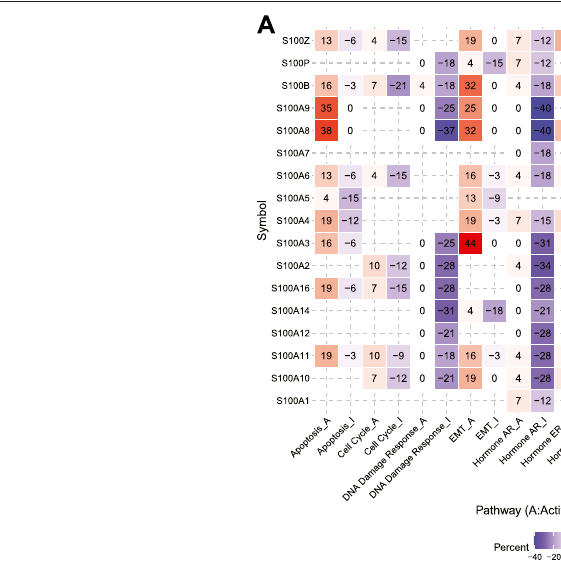
FIGURE8 | Cancer pathway activity and drug sensitivity analysisof theS100sin PAAD (GSCALite, n=178). (A) The roleof the S100s in the famous cancer-related pathways. (B) SpearmancorrelationshowedthatS100geneexpressionwasrelatedtosmalldrugs.Negativecorrelationmeansthathighgeneexpressionissensitiveto the drug, and vice